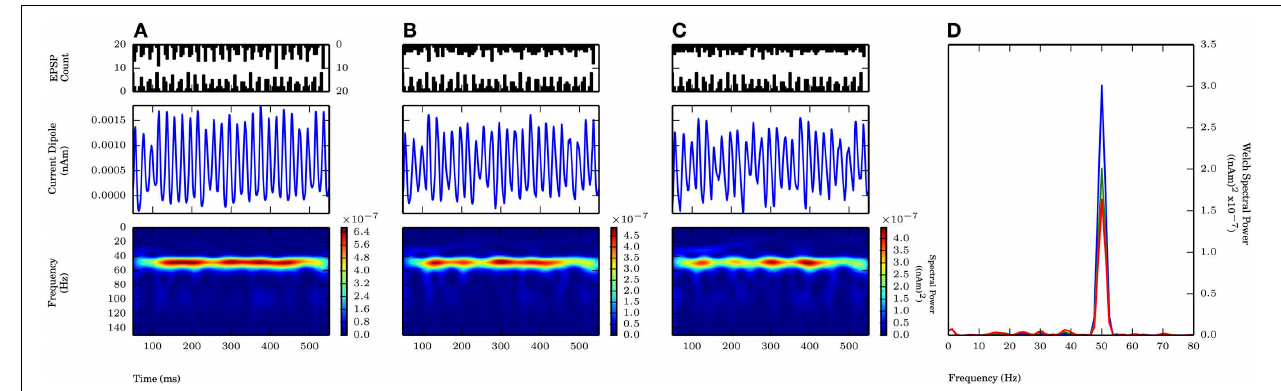
FIGURE 8 | Proximally driven subthreshold gamma enhanced with distal gamma periodic input and is robust to distal input noise. Ongoing 50Hz proximal input with σ p fixed at 2.5ms provided rhythmic 50Hz activity in current dipole. Distal input of 50Hz (offset 5ms on each cycle from proximal input, see Methods) with varied σ d at values of 2.5, 5.0, and 7.5ms. Panel configuration same as Figures 6 , 7 . Max. P W values all occurred here at 50.1Hz. (A) = 2 . 5ms: Persistent band of activity seen in Morlet spectrogram, σ d max. P W of 3 × 10 − 7 (nAm) 2 (blue trace in D ). P W increased compared to proximal only inputs with σ p of 2.5ms in Figure 6A (1.4 × 10 − 7 (nAm) 2 ). (B) σ d = 5 . 0ms: Band of activity persistent